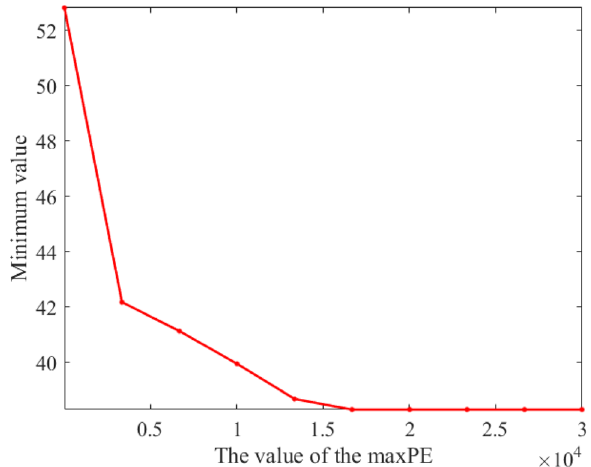
Fig. 9 Value of fitness function of Adam